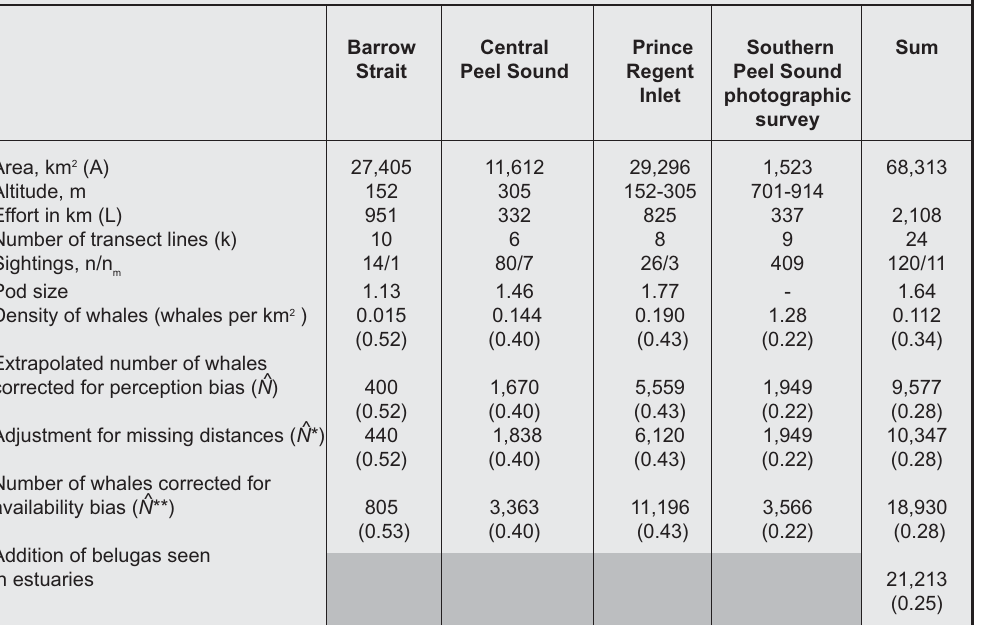
Table 5 . Survey estimates of beluga abundances in different regions (see Fig. 5) in the Canadian High Arctic in July-August 1996. The density in the unsurveyed northern part of Peel Sound is assumed to be similar to the density in central Peel Sound. The sightings are given as the total number of sightings (n) and the number with missing distances (n whales is corrected for an estimate of availability bias of 0.55 (cv= 0.04). Coefficient of varia- tion is shown in